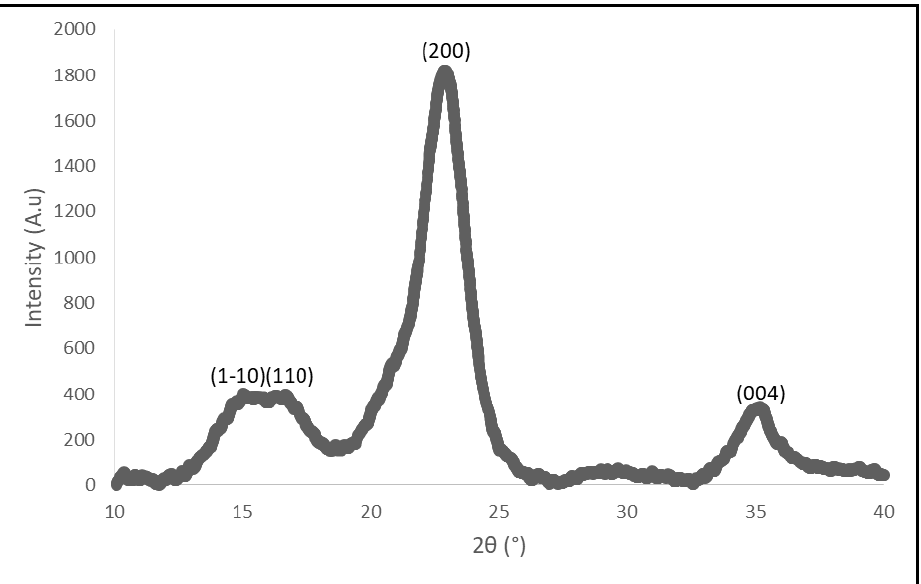
Figure 1. An X-ray diffraction pattern of paper sludge illustrating four main peaks (1–10, 110, 200 and 004) specific for cellulose Iβ.